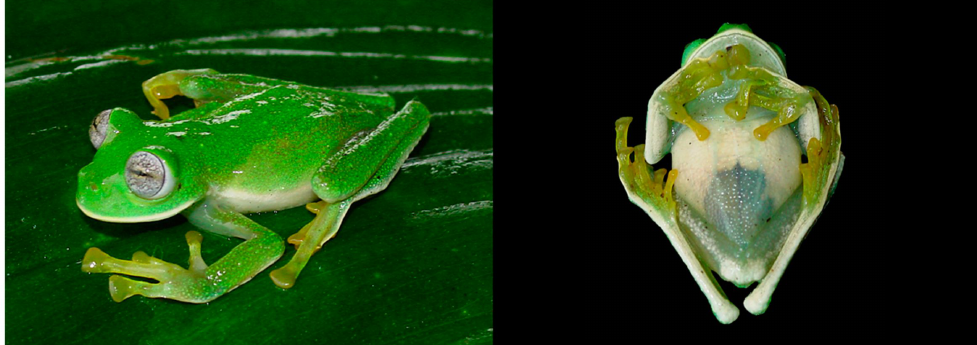
Figure 177. Nymphargus posadae in life. Adult male from Yanayacu Biological Station, 2100 m, Napo province, Ecuador, QCAZ 25090. Photos by Mart í n